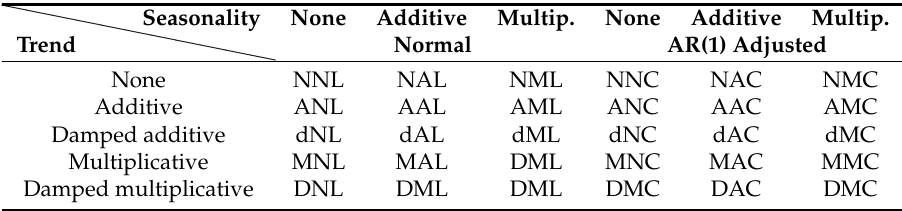
Table 1. Multiple seasonal Holt-Winters models’ nomenclature according to trend and seasonal